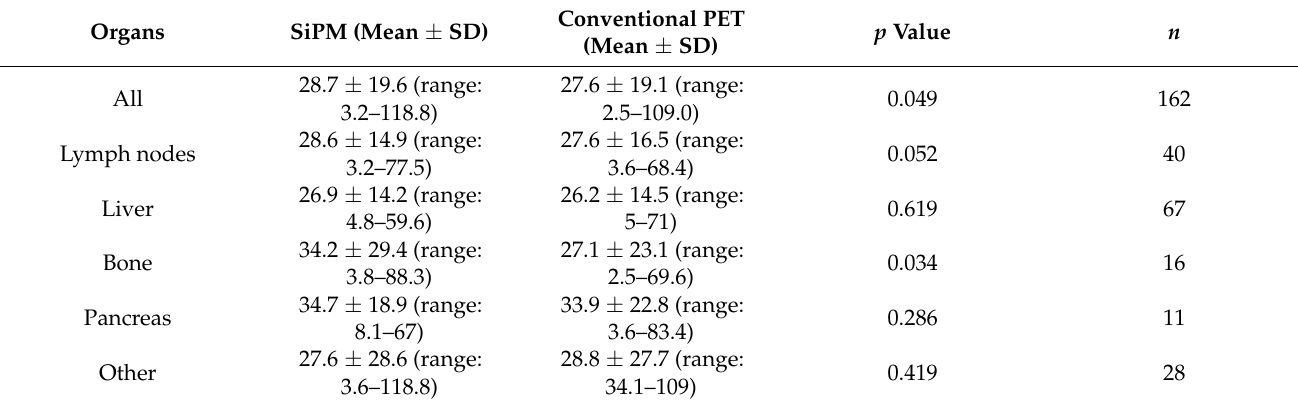
Table 2. Single organ analysis for patients who underwent SiPM PET/CT as first scan ( n = 52).